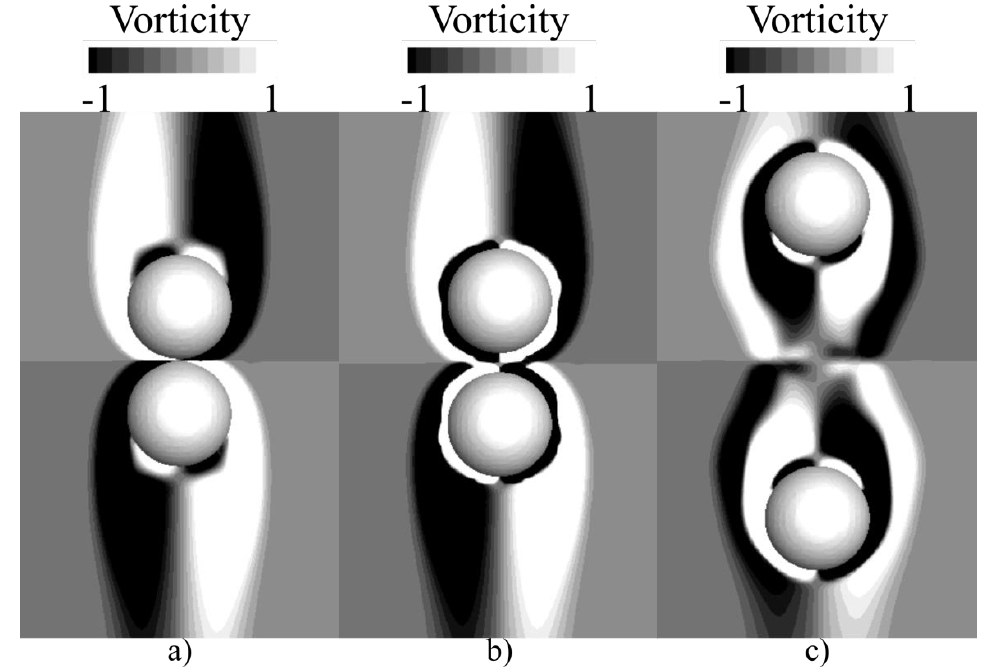
Figure 16. Vorticity distributions during a particle – particle collision: ( a ) t * = 0.0, ( b ) t * = 0.1, ( c ) t * = 1.0.